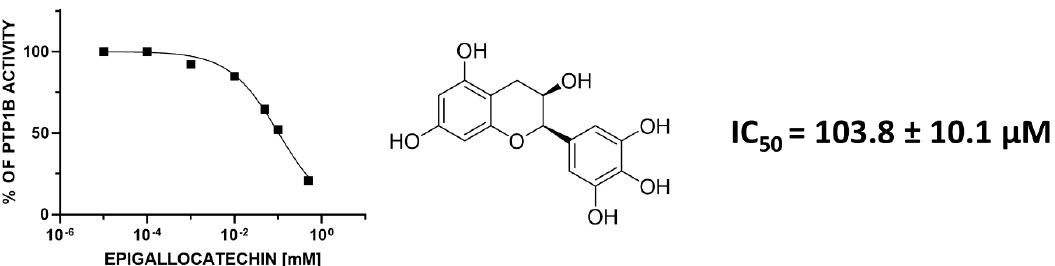
Figure 2. IC 50 value for epigallocatechin as PTP1B inhibitor.